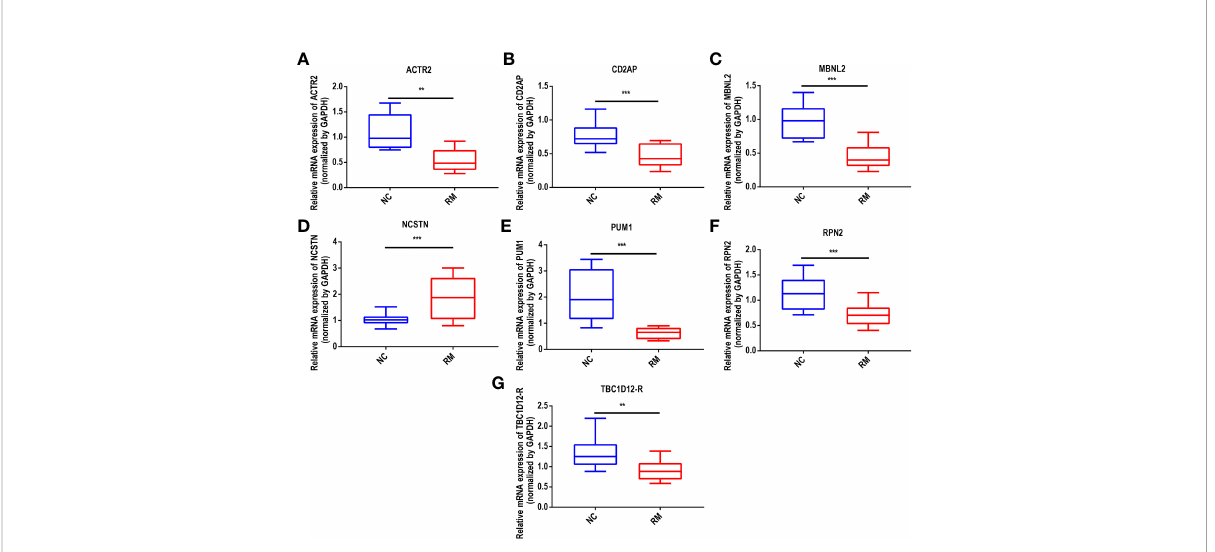
FIGURE 6 Expression validation of ACTR2 between normal and RM tissues. (A) ACTR2, (B) CD2AP, (C) MBNL2, (D) NCSTN, (E) PUM1, (F) RPN2 and (G) TBC1D12, "**p < 0.01, ***p <